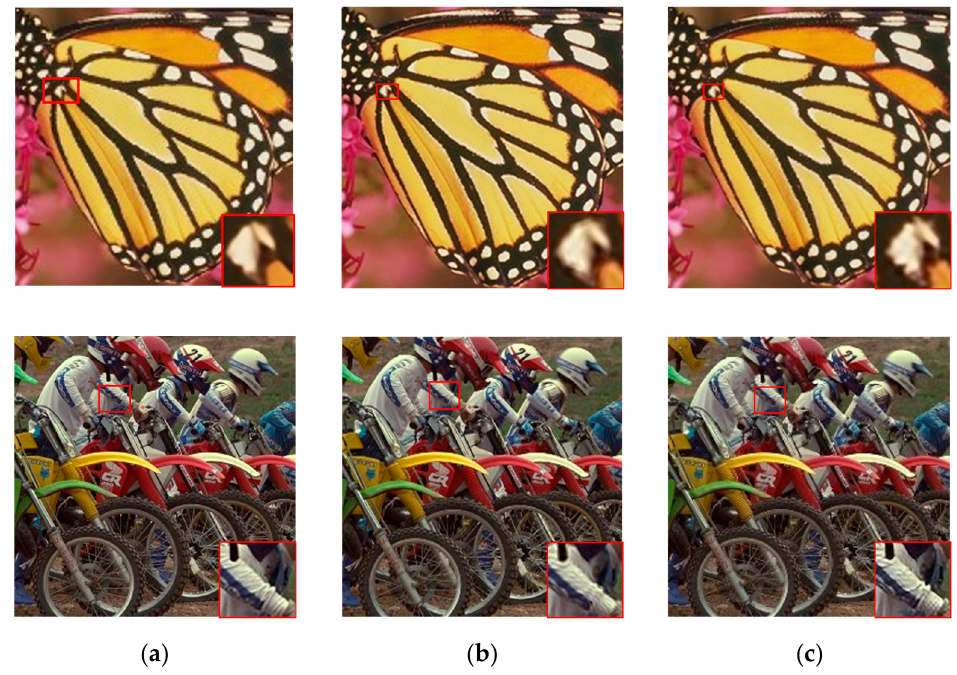
Figure 12. The comparison of color images interpolated by CGI and our method. ( a ) test image; ( b ) interpolation result by CGI; ( c ) interpolation result by GEI.